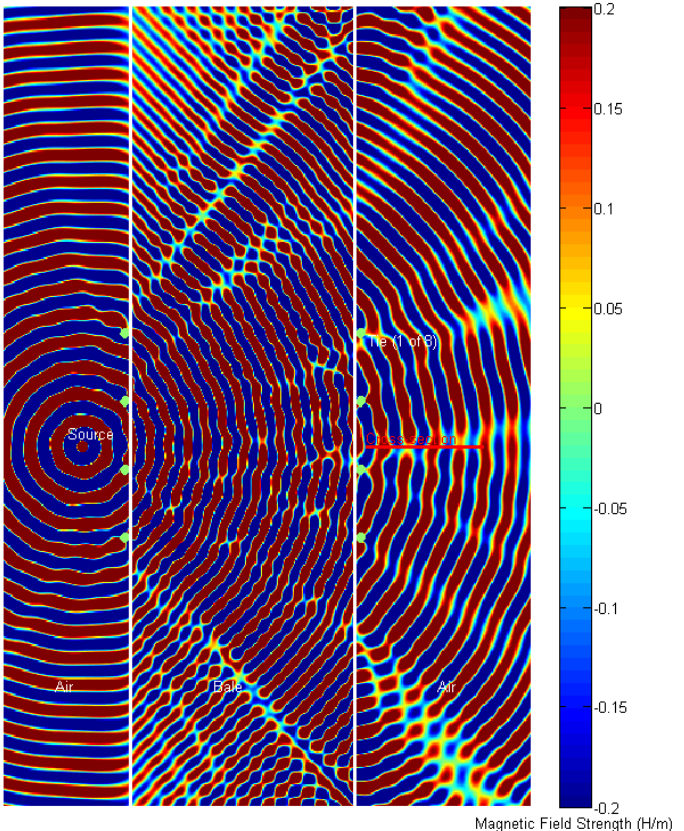
Figure 10. Another comparison of the two test cases, with versus without wire-ties from the final steady-state FDTD simulation, for a different offset from the wire-ties, again illustrating both the magnitude and phase shift that occurs due to the wire-ties. Lower view shows the cross-section comparison between the two test-cases.